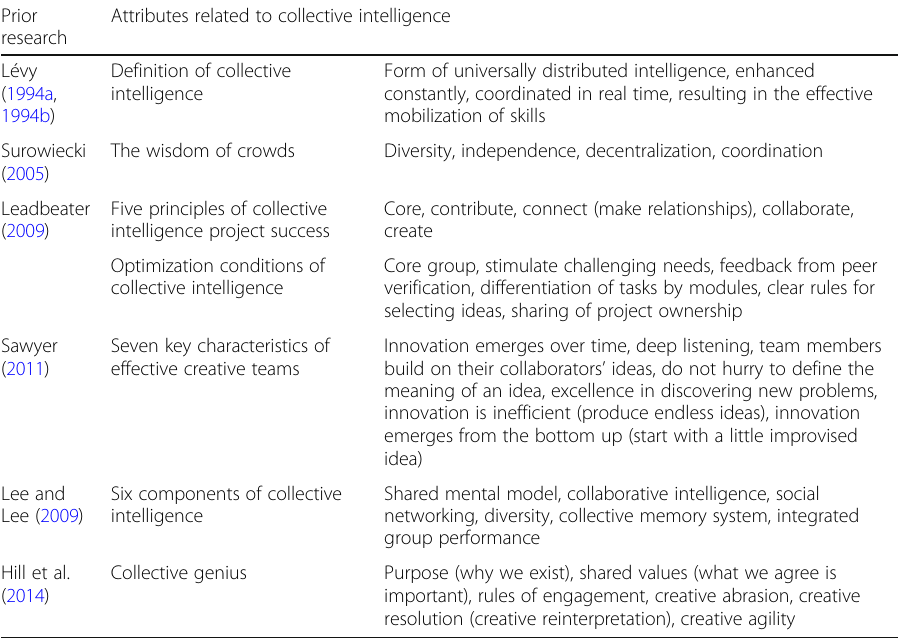
Table 2 Attribute related to collective intelligence Prior Attributes related to collective research